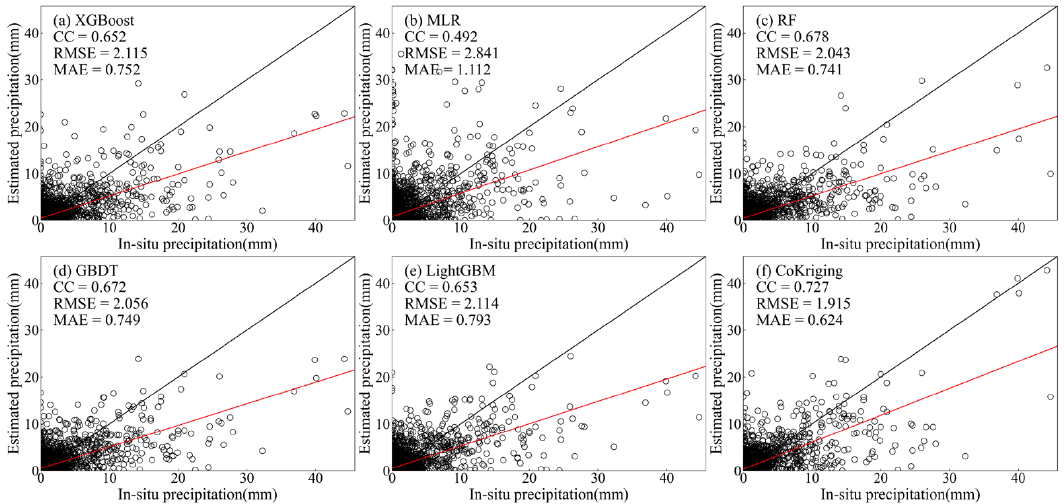
Figure 5. Comparison of the observed and estimated precipitation for heavy rainfall event III : (a) XGBoost, (b) MLR, (c) RF, (d) GBDT, (e) LightGBM, (f) CoKriging (the red line represents the fitted curve between in-situ and estimated precipitation; the black line represents that the ratio of in-situ precipitation to estimate precipitation is 1:1).